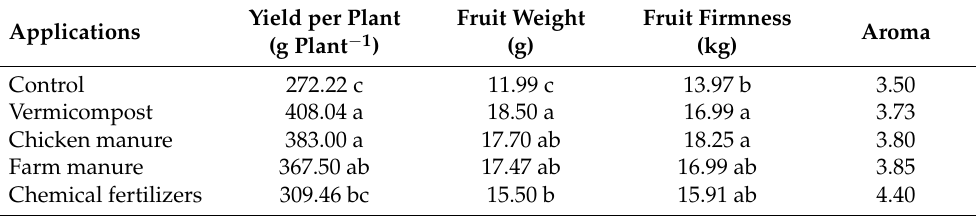
Table 4. Effects of fertilizer applications on yield per plant, fruit weight, fruit firmness, and aroma values.